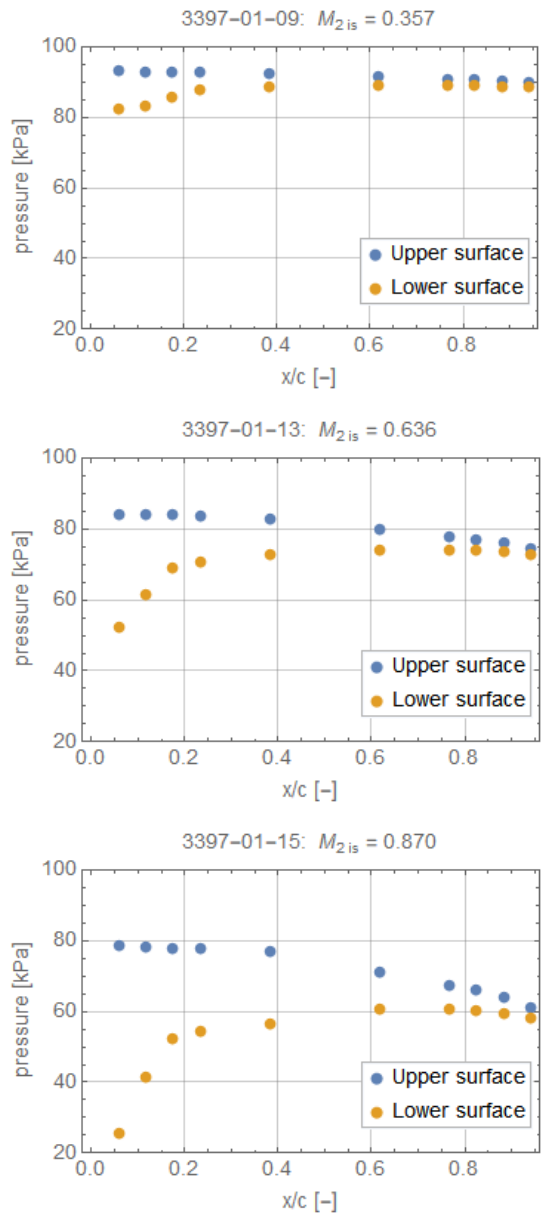
Figure 5. Distribution of the static pressure along the upper and lower surface of the middle blade for three flow regimes (values of the outlet isentropic Mach number 𝑀 2𝑖𝑠 ).